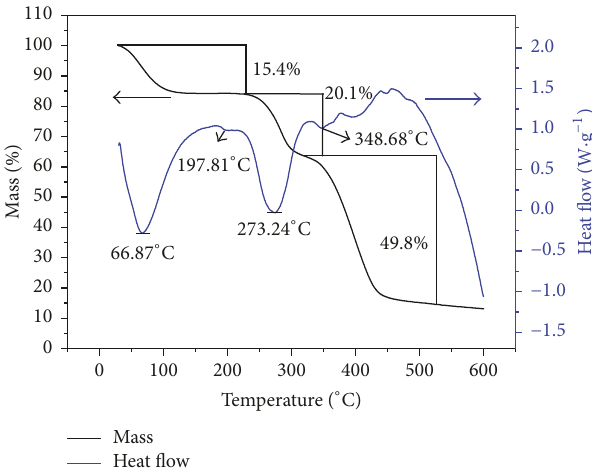
Figure 6: Thermal gravimetric curve of PADA.